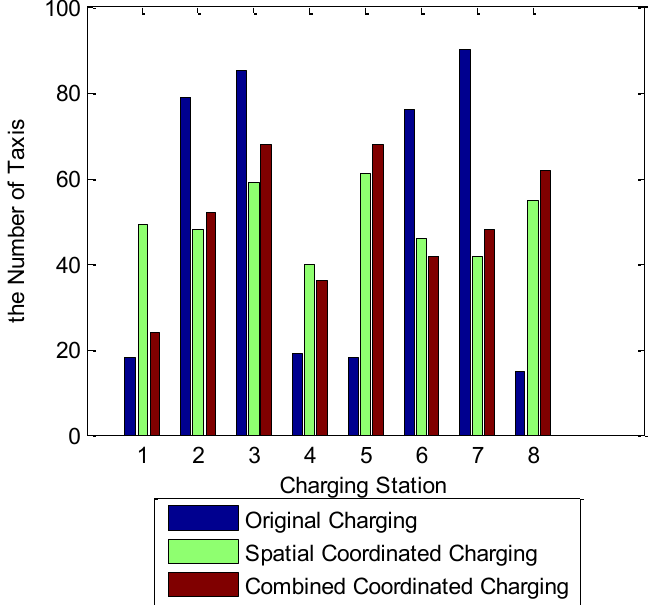
Figure 10. The comparison of original, spatial and combined coordinated charging